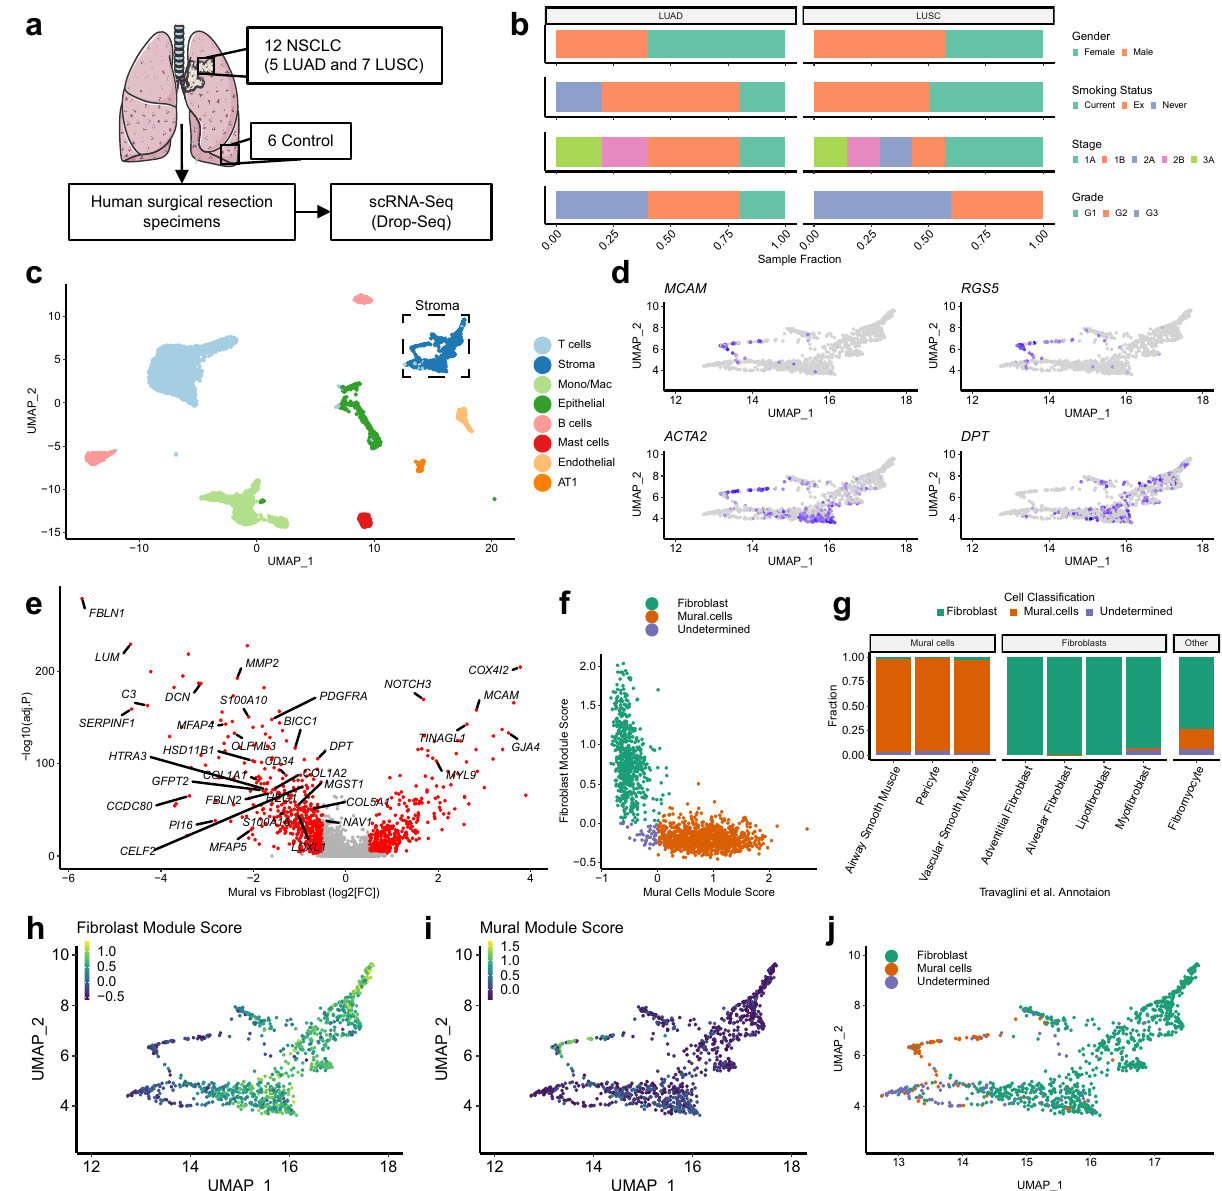
Fig.1|Fibroblastidenti fi cationthroughsingle-cellRNA-sequencinganalysisof whole-tissue homogenates derived from human NSCLC tumour samples. a Schematic illustrating sample processing and analysis methodology used to generate the target lung drop-seq (TLDS) dataset, comprised of human control ( n =6) and NSCLC ( n =12) samples. The Figure was partly generated using Servier Medical Art, provided by Servier, licensed under a Creative Commons Attribution 3.0 unported license. b Barplots showing key demographics of the TLDS dataset, further details provided in Supplementary Data 1. c . 2D visualisation (UMAP dimensionalityreduction)ofpooleddatafromallsamples ’ whole-tissuescRNA-seq data, highlighting different cell types. Further analysis is shown in Supplementary Fig. 1a – d. AT1 alveolar type 1 cells, Mono/Mac monocytes and macrophages. d Featureplotsshowingtheexpressionofcanonicalmarkersformuralcells( MCAM and RGS5 ), mural cells and myo fi broblasts ( ACTA2 ) and fi broblasts ( DPT) , in the